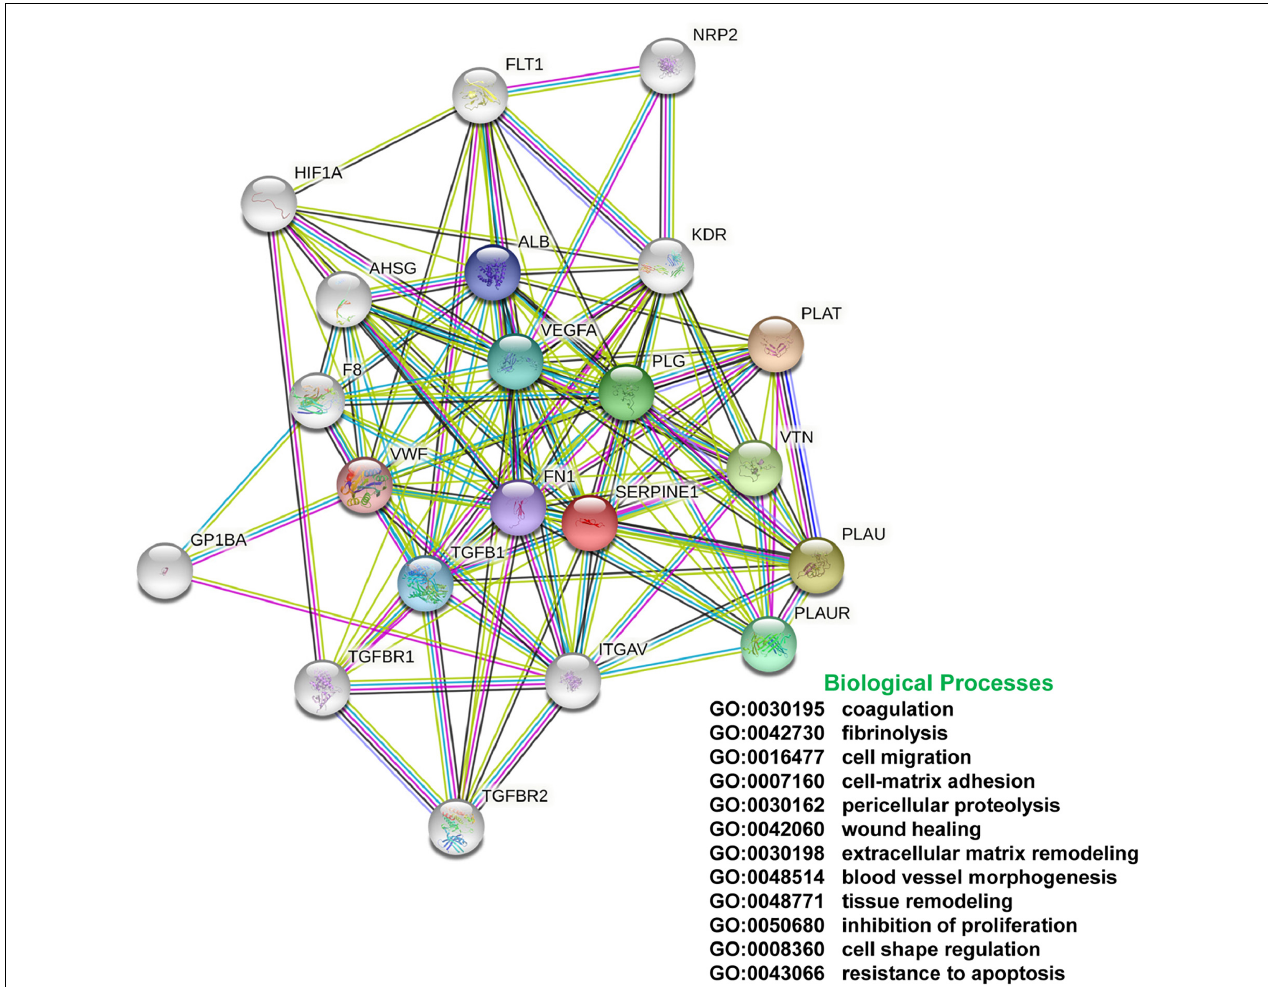
FIGURE 5 | String Network and Gene Ontology. Protein-protein interaction and GO analyses of the SERPINE1/TGF- β 1/fibronectin axis indicates that SERPINE1 is a significant nodal contributor to various biological processes that impact the global program of normal and maladaptive tissue repair. These data underscore the potential clinical utility of SERPINE1 targeting in the therapy of fibrotic